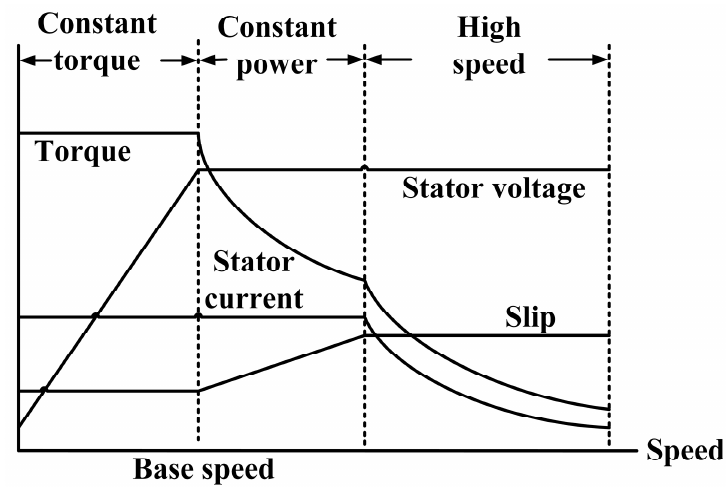
Figure 36. Induction motor drive characteristics. Maximum torque is maintained till base speed, and then decreases exponentially. Adapted from